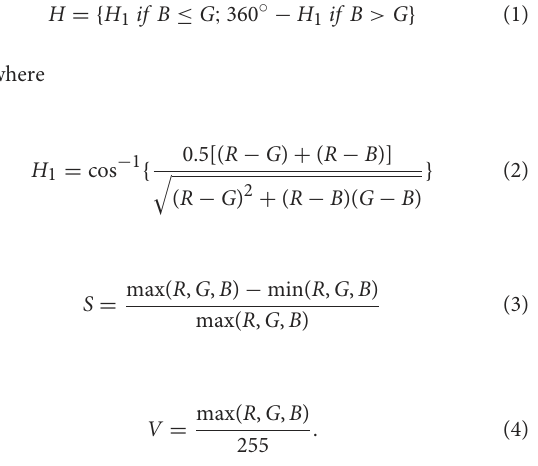
algorithm based on linear prediction Mayer frequency